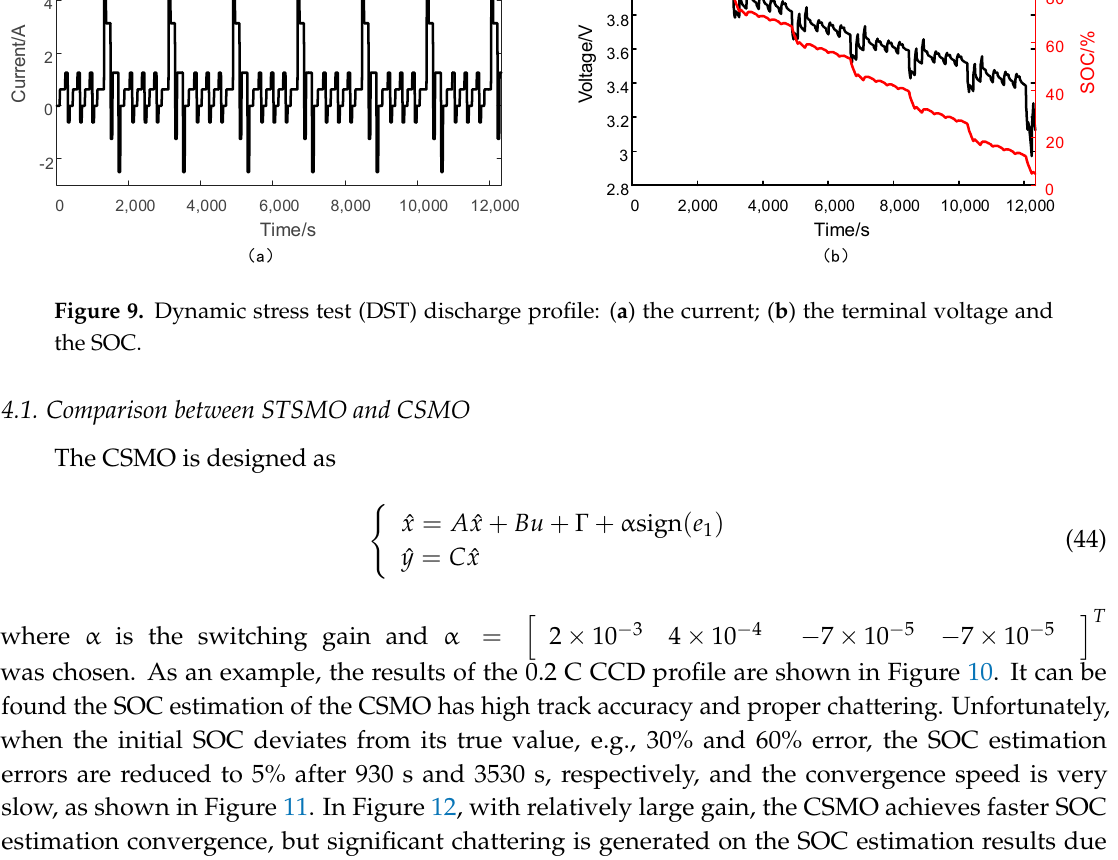
Figure 8. Configuration of the super-twisting sliding mode observer (STSMO) system.